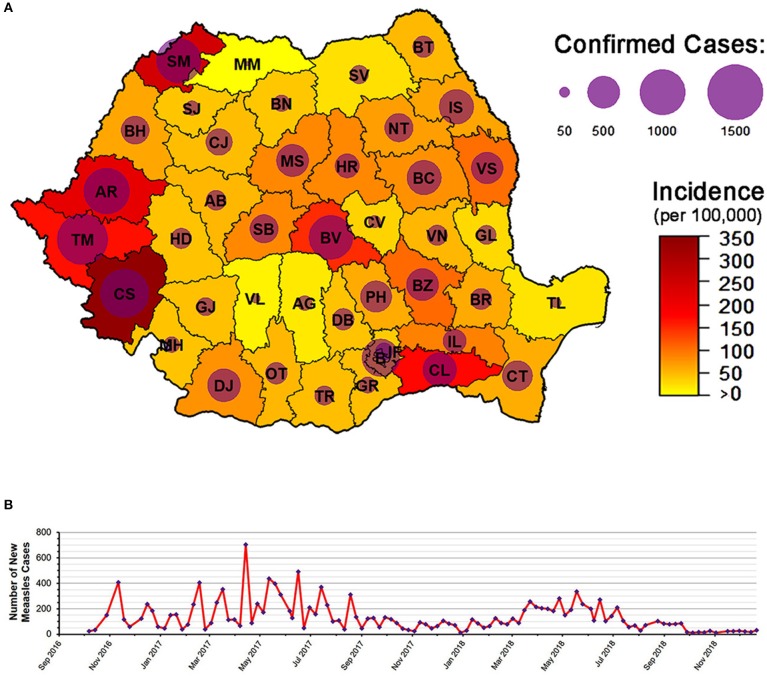
The 2016 Romanian measles epidemic. (A) The epidemic as of 21 December 2018: 15,587 total number of cases, with 59 confirmed deaths. County codes are depicted in the figure. (B) Number of new measles cases from October 2016 to December 2018. Figure based on data from the weekly reports released by the Romanian National Center for the Surveillance and Control of Communicable Diseases (CNSCBT). For the evolution of the epidemic by county, see Supplementary Video. Epidemic data (at national level) is available in Supplementary Table 3.